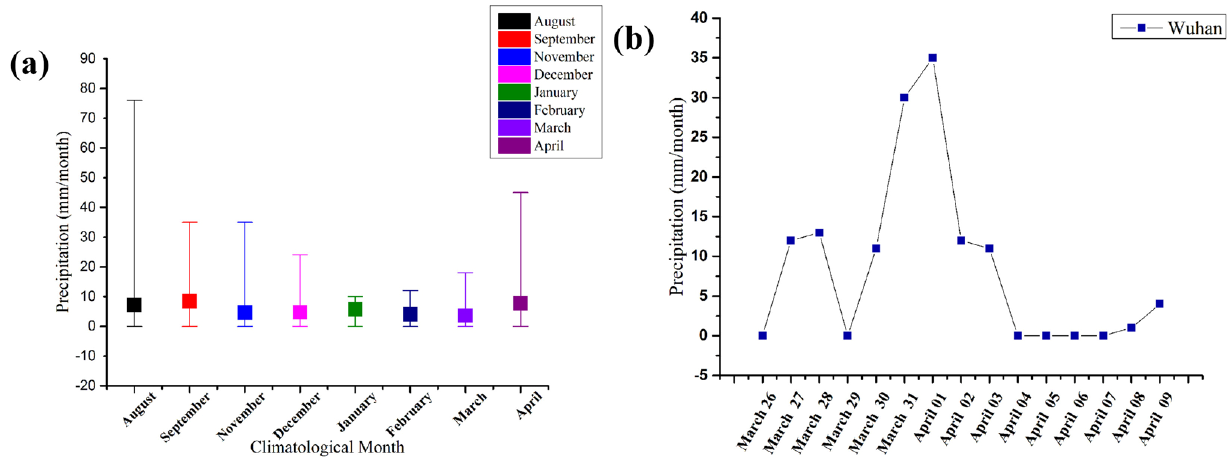
Figure 11. ( a ) The mean climatological monthly precipitation (TRMM data in mm/month) and standard deviation from August 2014 to April 2015 in Wuhan city; ( b ) daily precipitation (mm/day) from 26 March 2015 through 9 April 2015 in Wuhan